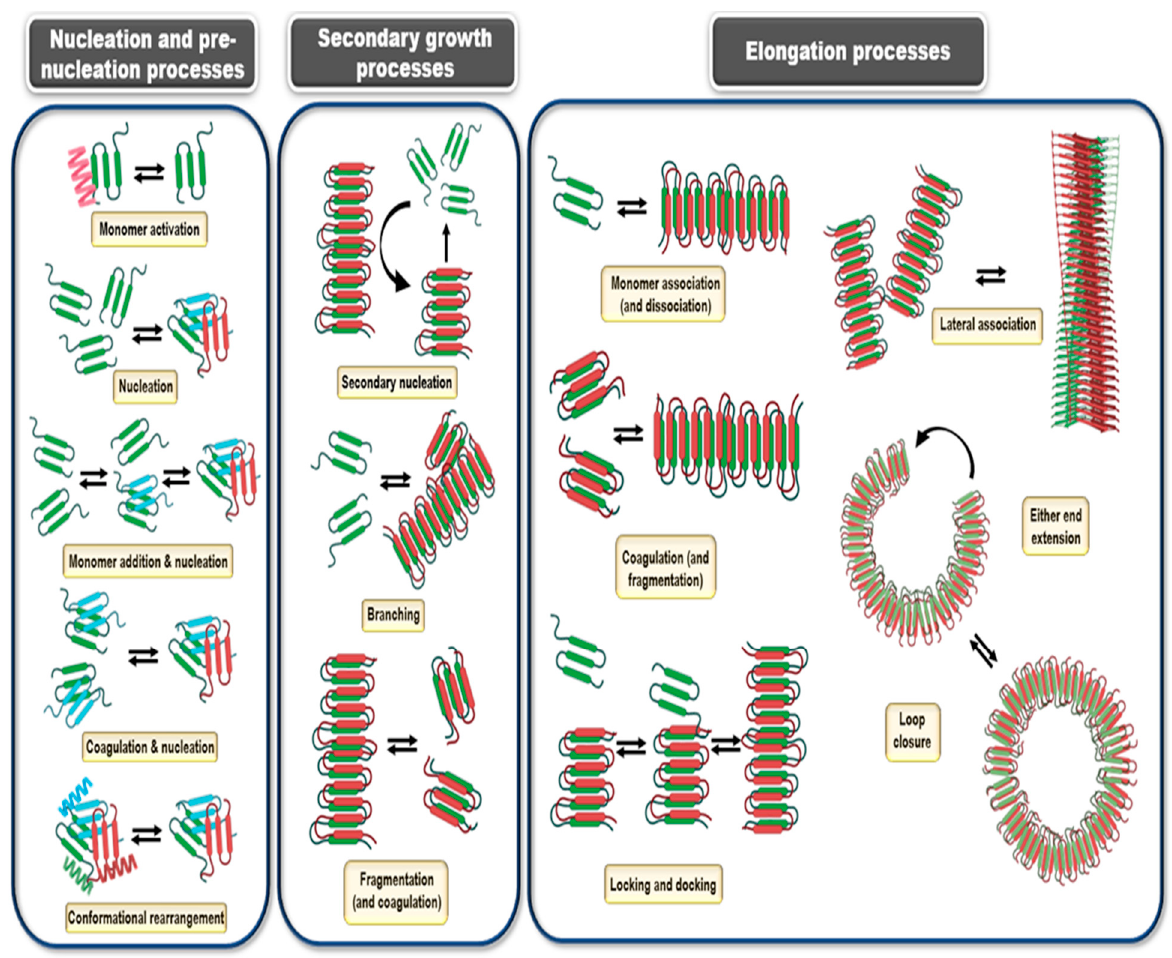
Figure 8. Self-assembly of amyloid fibrils is triggered and facilitated by a number of preceding processes, which include prenucleation and nucleation, secondary growth, and elongation processes, occurring both chronologically and simultaneously to yield the thermodynamically stable fibrils.